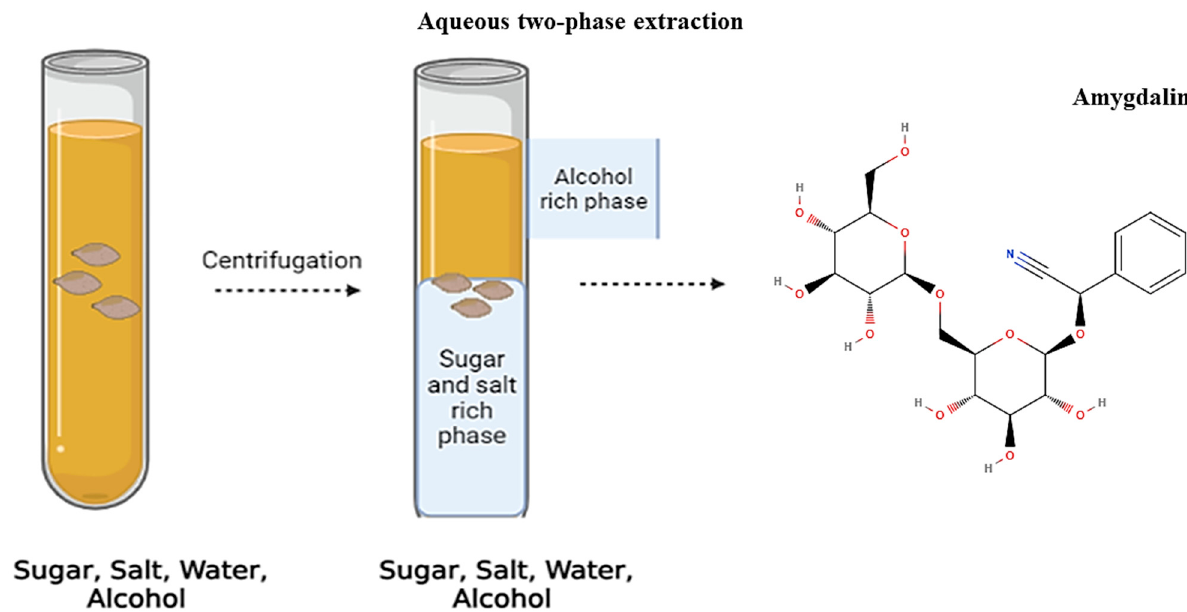
Figure 3. A two-phase extraction method for extraction of amygdalin .